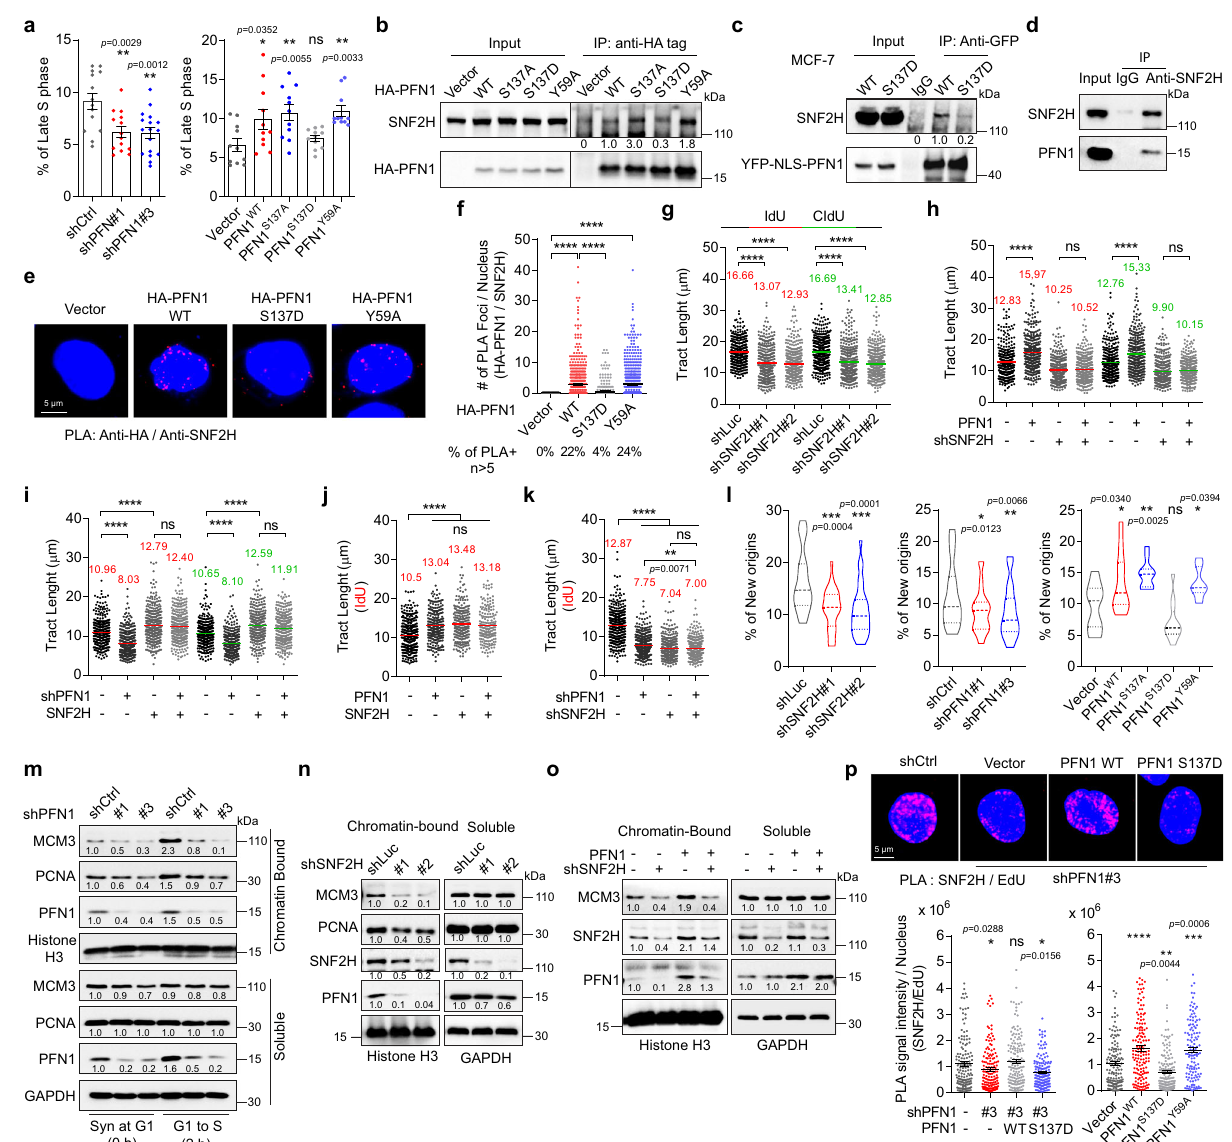
Fig. 2 | PFN1 and SNF2H function together to promote DNA replication. a PercentagesofEdU-labeled(10 μ M,25min)PFN1knockdownandoverexpressing MCF-10A cells in late S-phase. Data are mean±SEM of n =3 independent experi- ments containing about 3000 cells per group. P -values were based on One-Way ANOVA and Dunnett ’ s multiple comparisons test. b Anti-HA pulldown using transfected HEK293T cells. c Anti-GFP pulldown using MCF-7 cells expressing YFP orYFP-NLS-PFN1.Detailsforquanti fi cationandnormalizationofSNF2Hintensities aredescribedintheMethodssection. d Anti-SNF2HpulldownusingparentalMCF- 10A cells. e , f PLA between HA-PFN1 and endogenous SNF2H in HeLa cells. Scale bar, 5 µ m. Around 500 nuclei were quanti fi ed as in (1 b ). g , h DNA fi ber analysis in MCF-10Acells. i , j DNA fi beranalysisinHEK293Tcells. k DNA fi beranalysisinMCF- 7 cells. For ( g – k ), atleast 300 fi bers were analyzed per condition. l Percentages of DNA fi bersrepresentingnewly fi redorigins(CIdUonlyandCIdU-IdU-CIdU)inMCF- 10A cells with SNF2H or PFN1 knockdown or PFN1 overexpression. Data are mean±SEMof n =2independentexperimentswitharound3000 fi berspergroup.